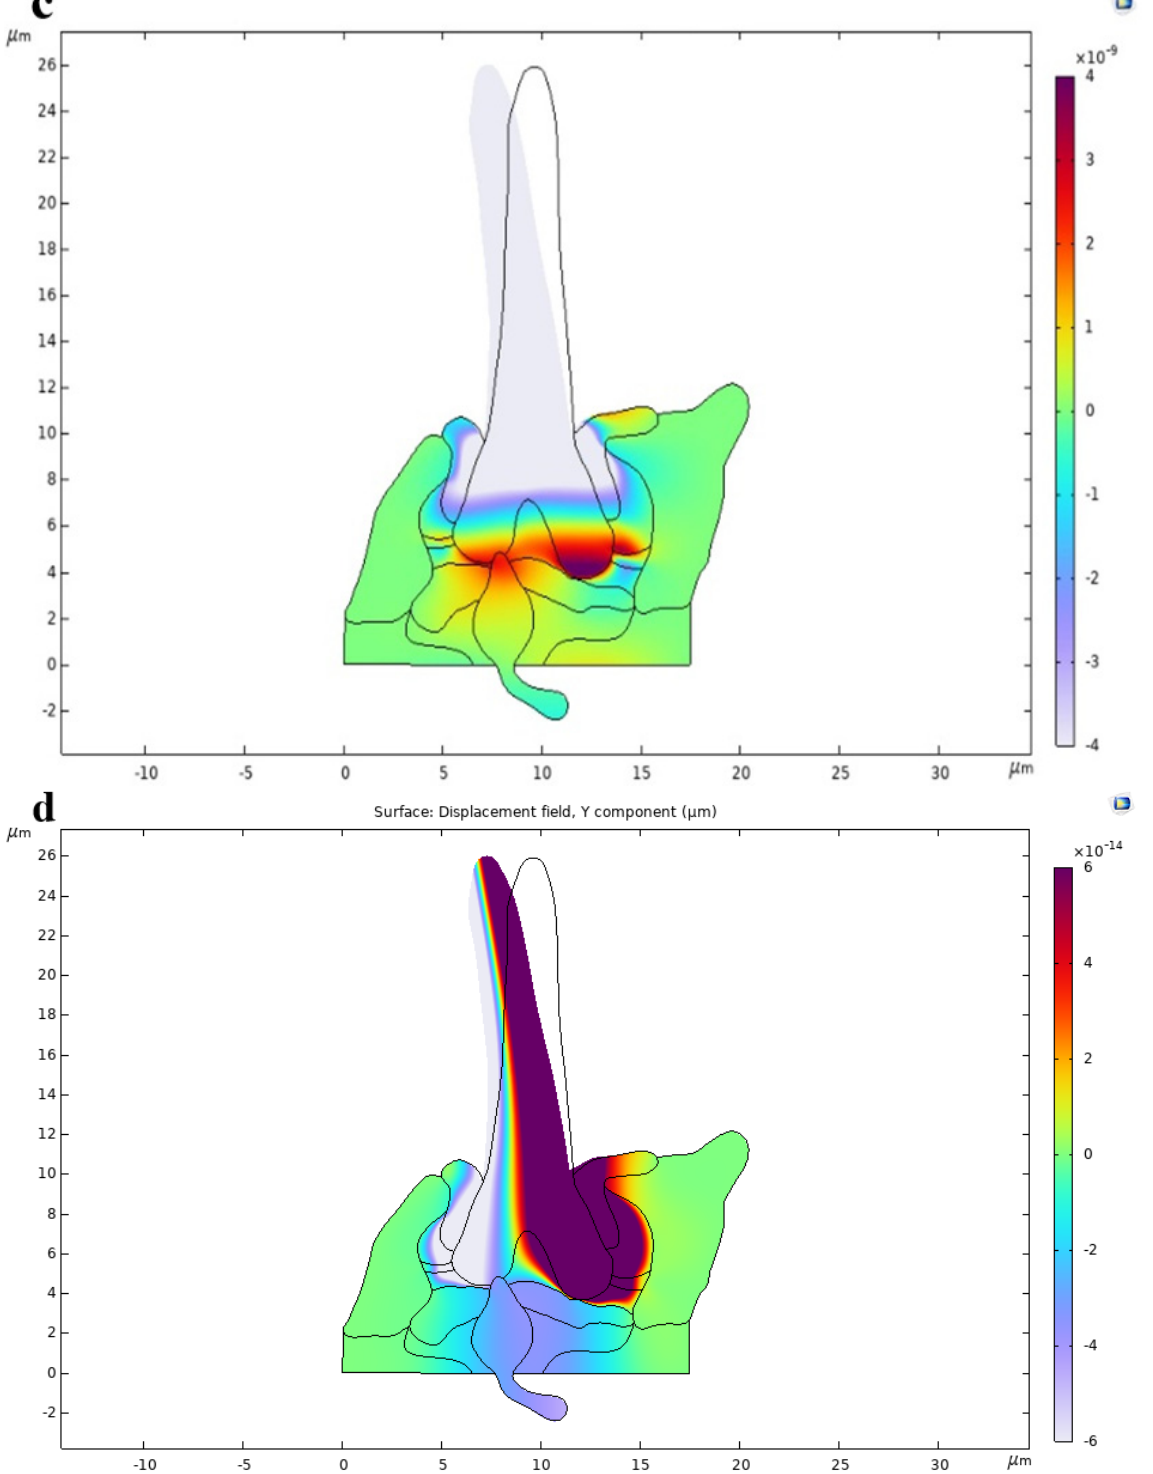
Figure 6. Identification of the parameters (point of rotation, hair-shaft deflection) for the Trichoid sensilla due to applied force on the hair shaft. ( a ) Displacement magnitude, point of rotation near the hair base, and the dendrite connection. ( b ) Deflection angles of hair shaft at the distal tip and the basal part of hair. ( c ) Dendrite sheath displacement field along the horizontal axis. ( d ) Dendrite sheath displacement field along the vertical